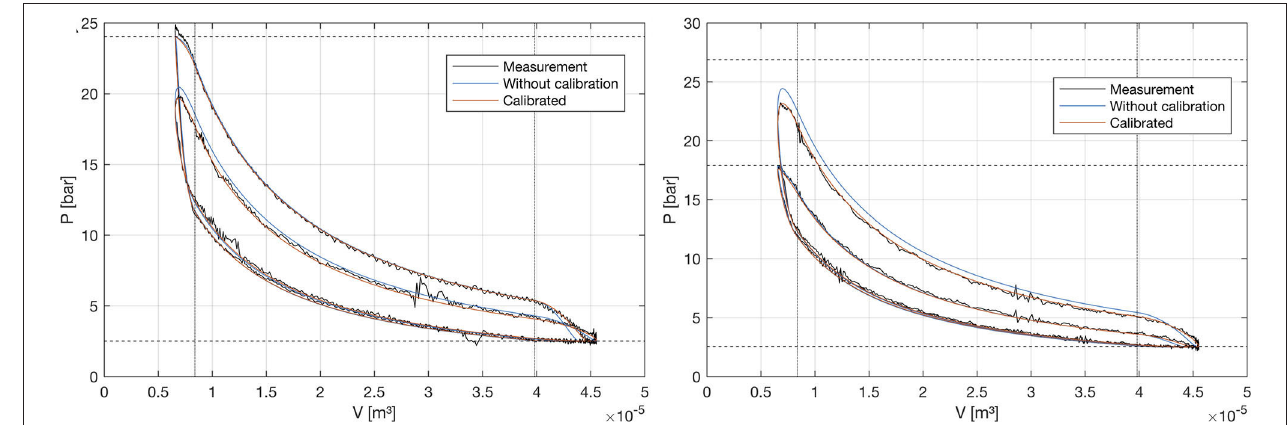
FIGURE 10 | Comparison between measured and simulated indicated powers, shaft powers, mass flow rates, and exhaust temperatures.